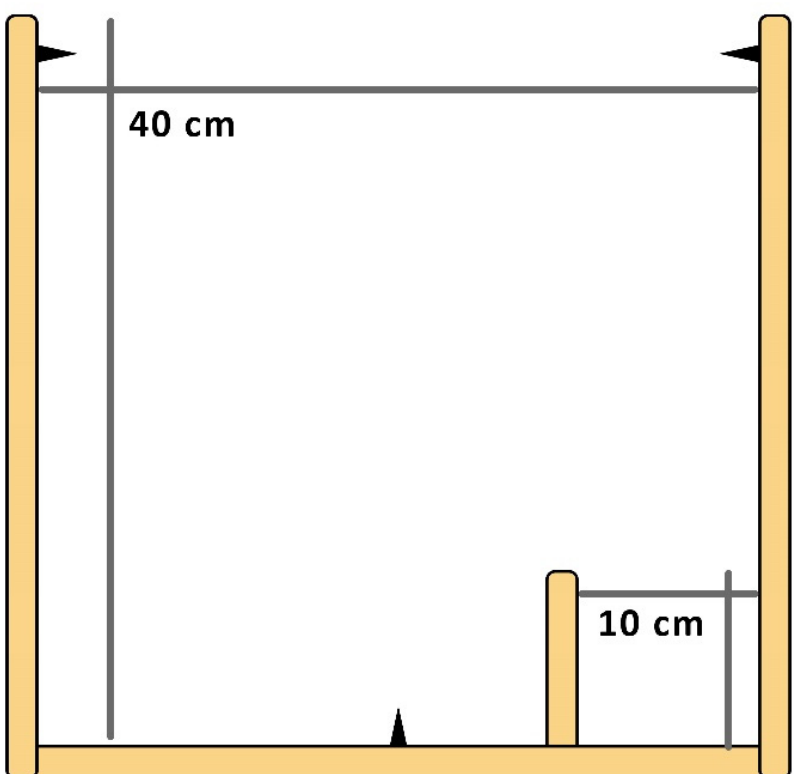
Figure 3. Common Non-Forested Vegetation Sampling Protocol (CNVSP) herbaceous monitoring frame used in the study, based on Rhodes et al. 2014 [9]. The frame consists of a 40 × 40 cm plot, with a 10 × 10 cm subplot. Three basal-hit pins are located around the perimeter of the